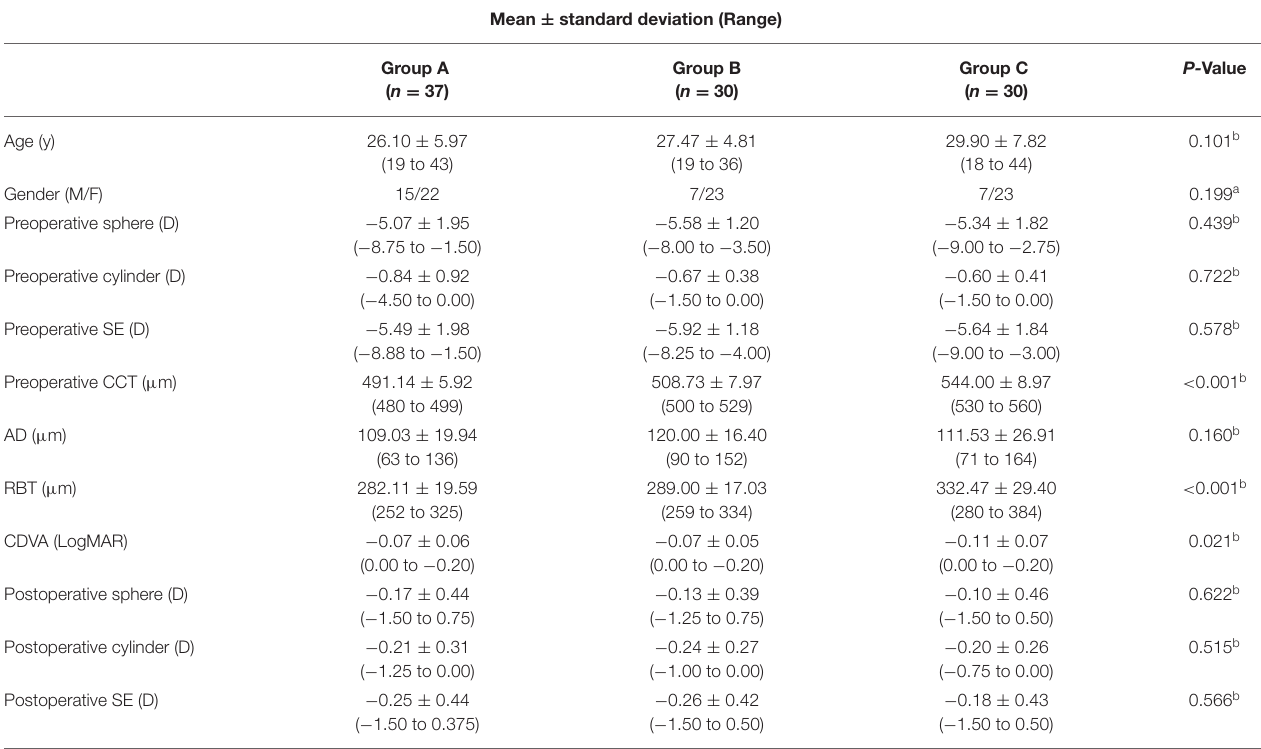
TABLE 1 | Patient demographic information in different groups (mean ± standard